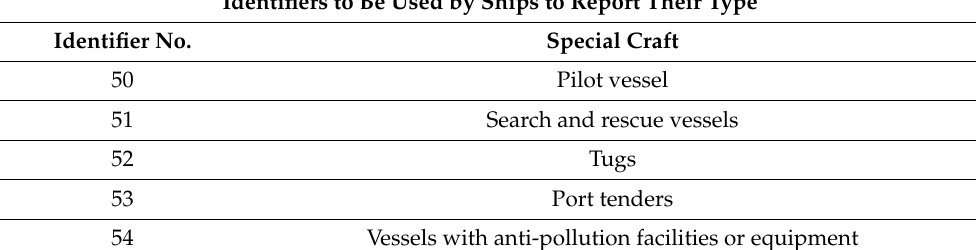
Table 1. Division of ships into types used in AIS [31], p. 114.